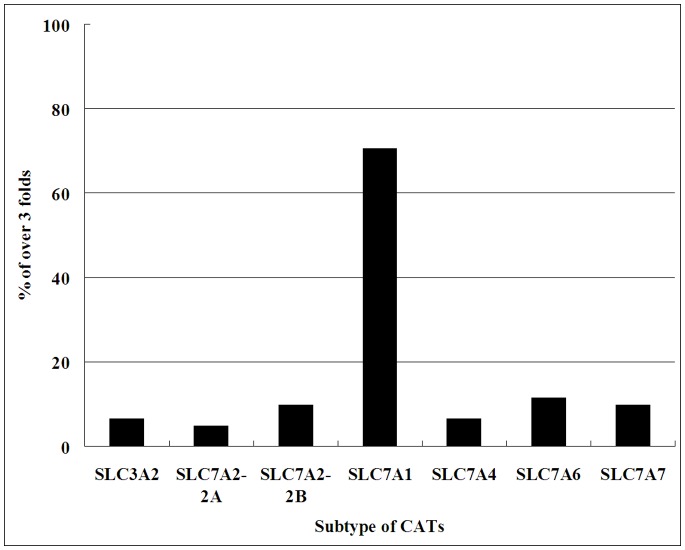
Overexpression of CAT mRNA in tumor relative to normal colon.The expression of CAT mRNA in colorectal cancer tissues was measured by qRT-PCR, and overexpression was defined as at least 3-fold higher expression than that in normal colon tissue. The figure shows the percentage of samples with overexpression (>3 fold) of individual arginine transporter genes among122 CRC tissue samples. The CAT-1 gene was overexpressed in 86 of 122 (70.5%) CRC tissues.